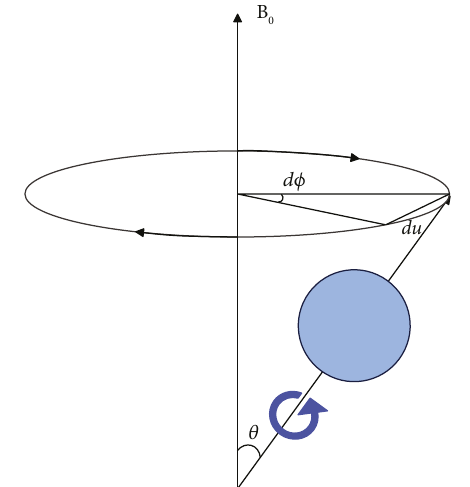
Figure 3: Mathematical analysis of photon precession.